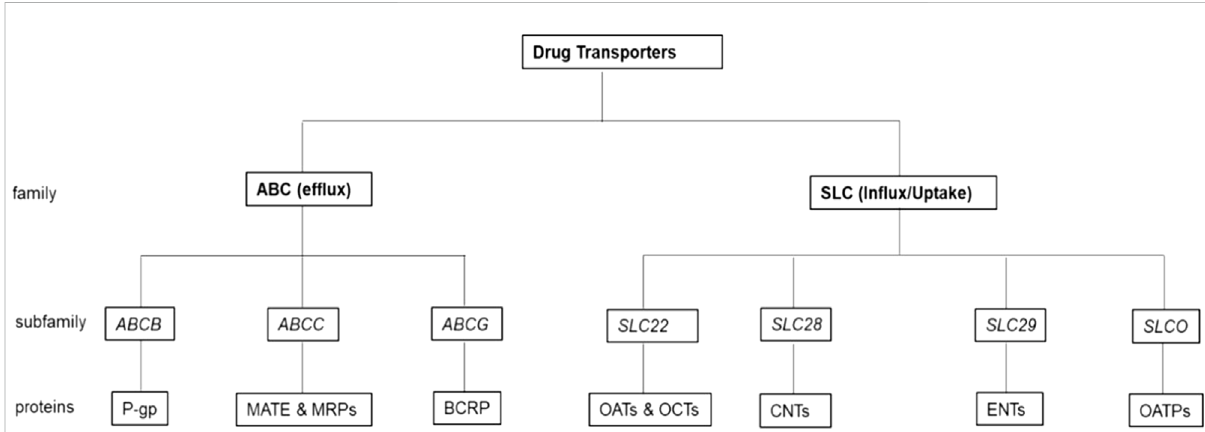
FIGURE 1 Drug transporters most relevant in the ef fl ux and in fl ux of PrEP drugs . In the ABC (ef fl ux) family there are three-drug transporter subfamilies along with their respective proteins that are the most relevant in the ef fl ux of PrEP drugs, while in the SLC (in fl ux/uptake) family, there are four drug transporter subfamilies along with their respective proteins that are the most relevant in the uptake or in fl ux of